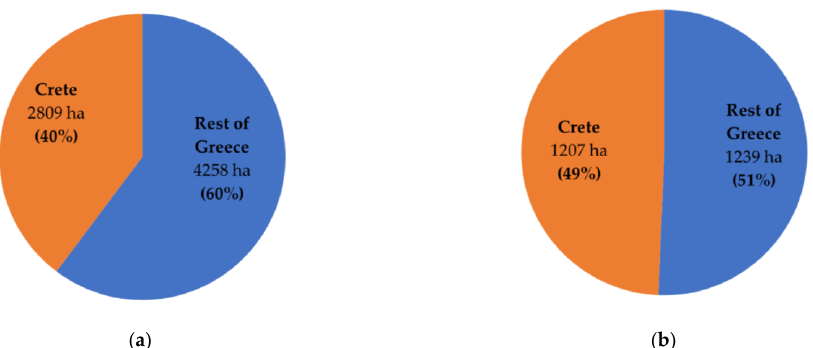
Figure 1. Greenhouse cultivation areas by ( a ) vegetables and ( b ) tomatoes on Crete Island in relation to the rest of Greece.